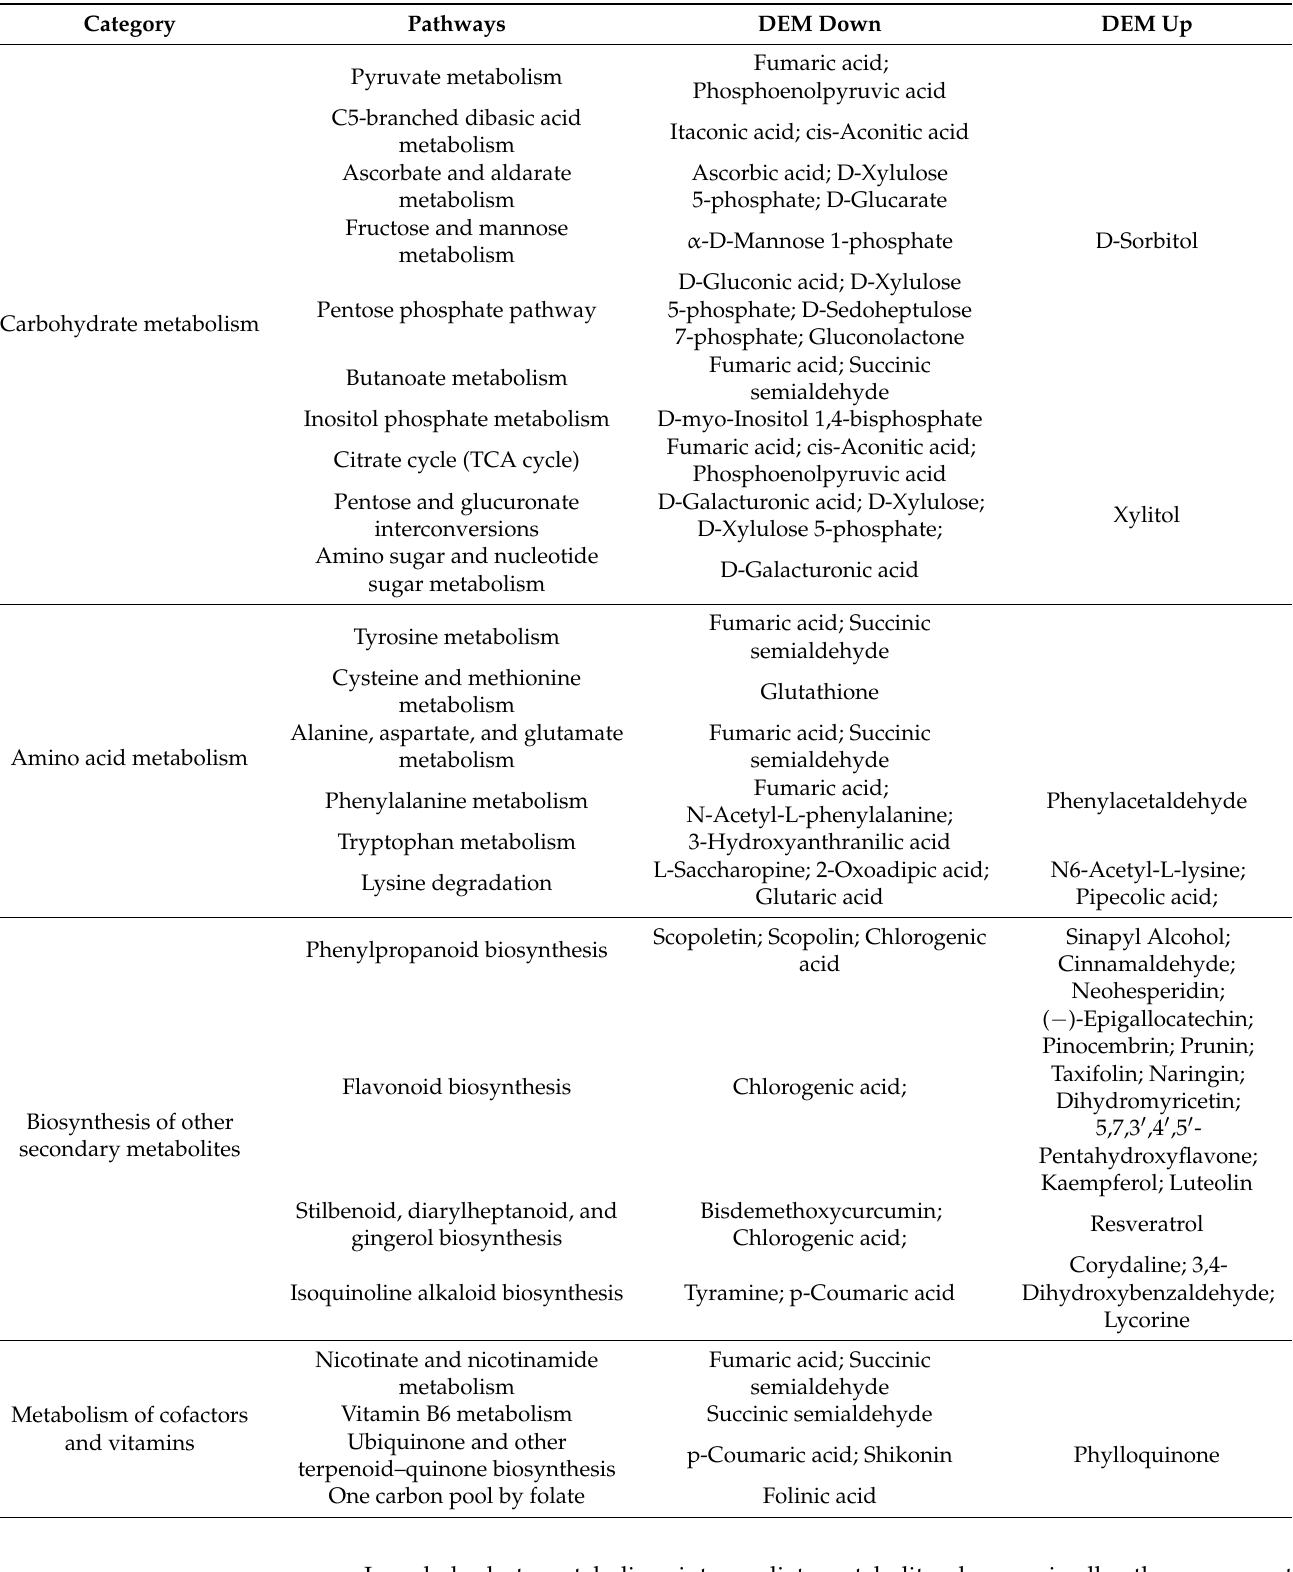
Table 2. Metabolomic and transcriptomic co-enrichment results in pathway entries and expression of DEGs and